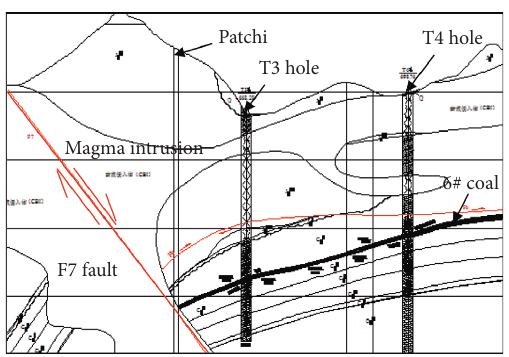
Figure 4: Schematic diagram of ground impacts caused by mining earthquakes in working face